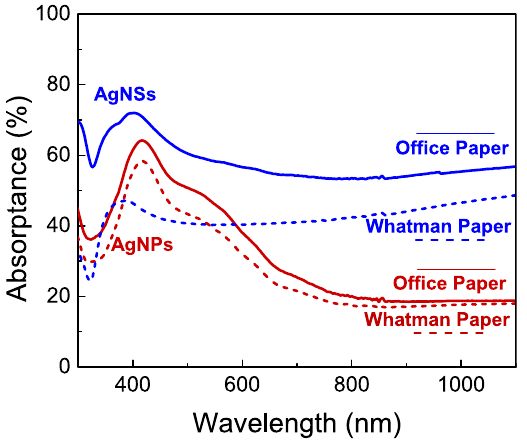
Figure 5. UV-VIS-NIR spectra of plasmonic paper substrates (Office paper – solid lines; and Whatman no. 1 paper – dashed lines), containing drop-cast AgNPs (red lines) or AgNSs (blue